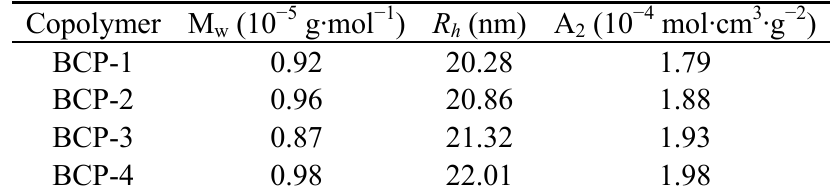
Table 3. Molecular and thermodynamic parameters of copolymers determined by light scattering technique in THF at 23 ° C.